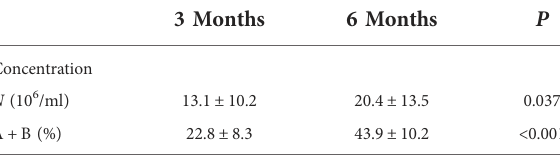
TABLE 2 Comparison of sperm concentration and sperm motility of 25 patients at 3 and 6 months after